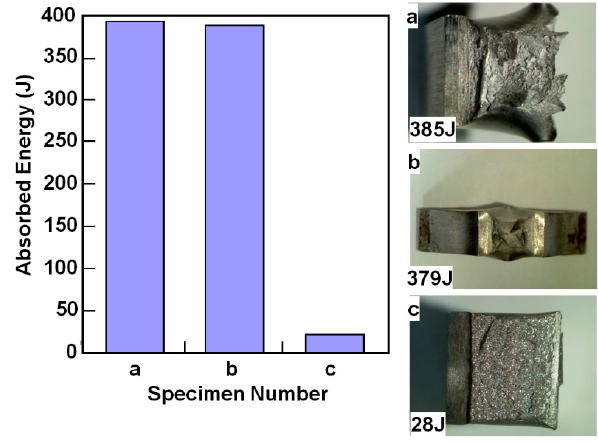
Figure 2. Absorbed energy of Charpy impact test of steel specimens ( left ): a = 385J, b = 379J, c = 28J and corresponding images of the fractured specimens ( right ).